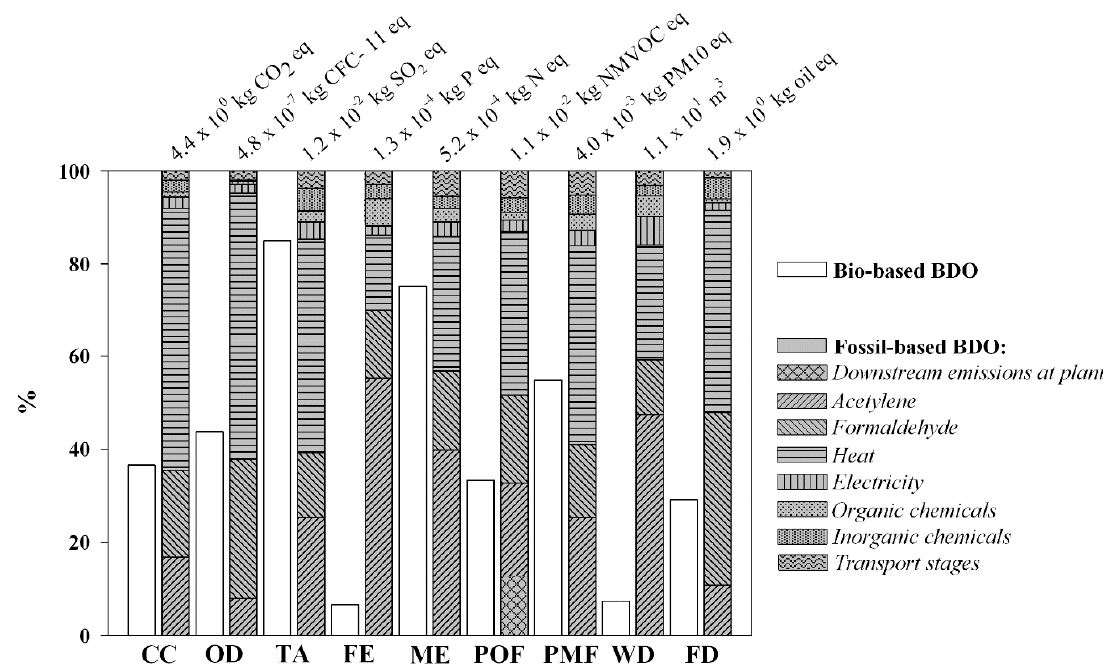
Figure 4. The characterization graph shows the comparison between 1 kg of bio-based BDO and 1 kg of fossil-based BDO. The figure also details the contribution from the different input process to the total impacts of the fossil-based BDO production (“butane-1,4-diol, at plant” record, from EcoInvent database v. 2.02).